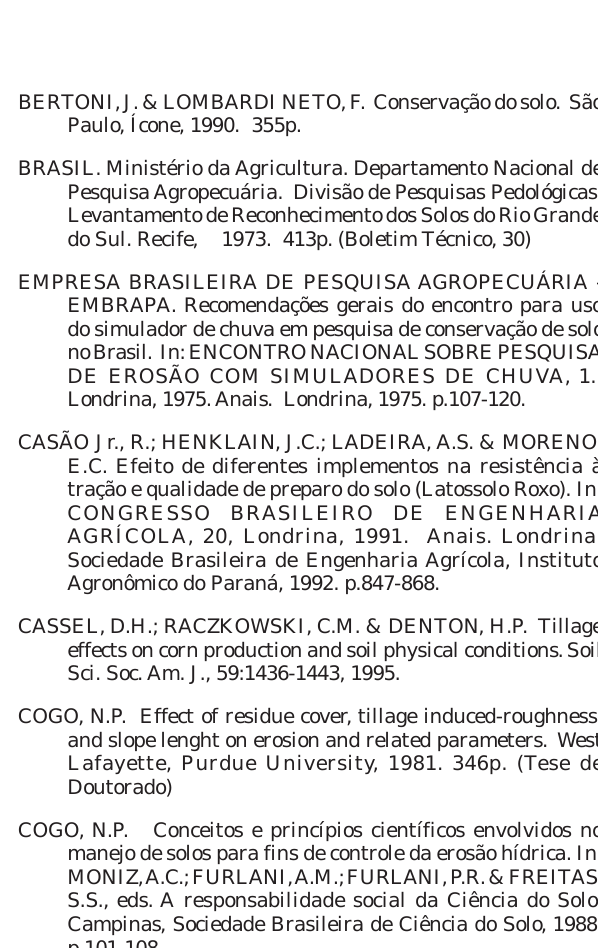
Figura 2. Perda total de água por enxurrada, em relação a quantidade total aplicada em todas as chuvas, nos quatro testes realizados na cultura do milho, nos tratamentos estudados (A-M = aveia-milho; SC- M = sem cobertura-milho; SC-SC = sem cobertura-sem cobertura; PDA = plantio direto tração animal; PDT = plantio direto tratorizado; PCA = preparo convencional tração animal; PCT = preparo convencional